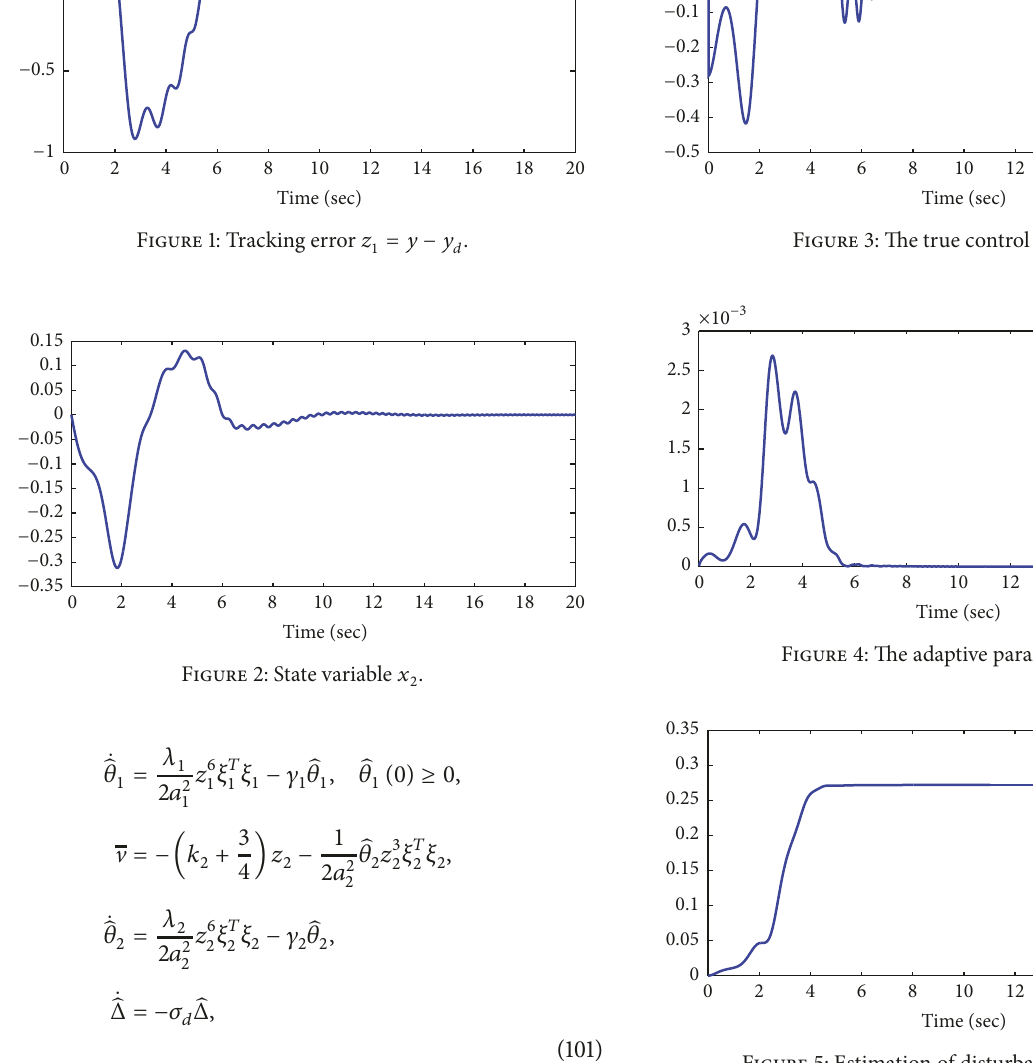
Figure 5: Estimation of disturbance bound